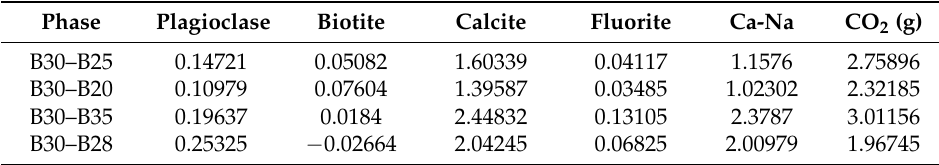
Table 2. Results of mass transfer along the groundwater flow from highland to the rift part of the basin (All mineral and gas mass transfers are in mmol/kg H 2